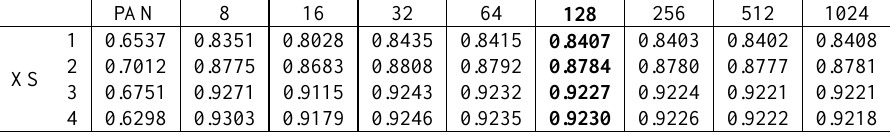
Table 4. CC between QuickBird multispectral and fused images using BR with different block